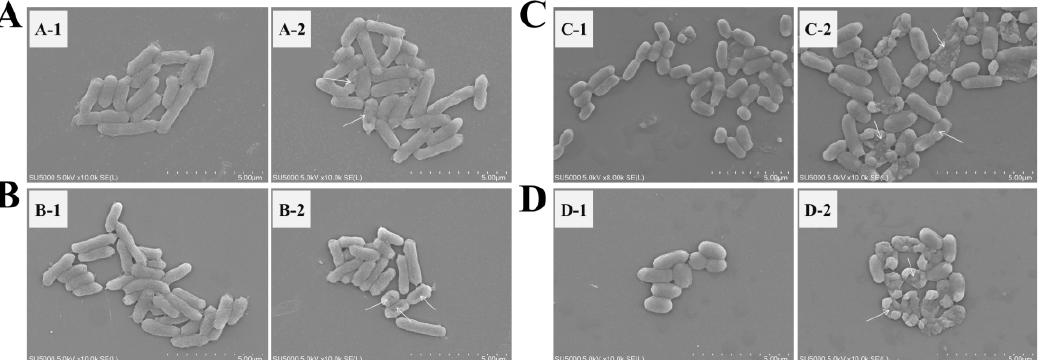
Figure 8. Effects of the curcumin-medicated PDI on the outer membranes of the four bacterial cells. ( A )–( D ) E. coli , L. monocytogenes , S. putrefaciens , and V. parahaemolyticus , respectively. ( A-1 )–( D-1 ) L − C − ; ( A-2 )–( D-2 ) 15.96 J/cm 2 and 0.1 mM Cur.